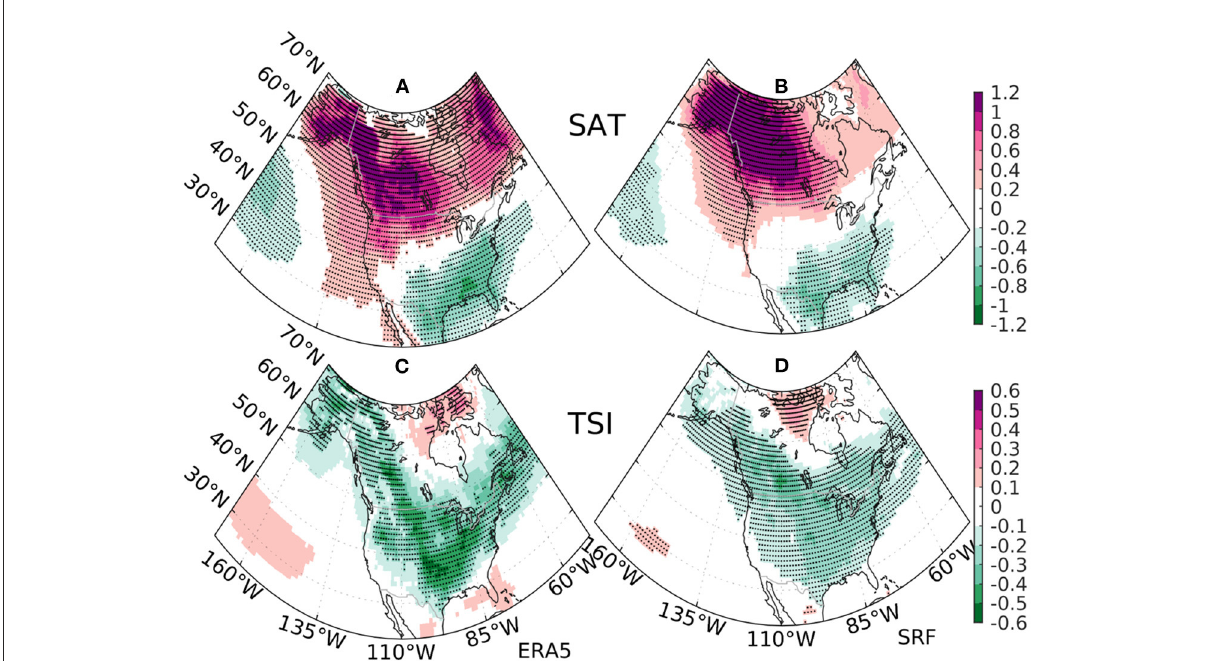
FIGURE9 The regression pattern onto the observed normalized PNA index for the DJF surface air temperature (SAT) (units in K) during 1992–2022 from (A) ERA5 reanalysis and (B) the ensemble mean estimates of SPEAR’s SRF. The same regression pattern for the DJF Temperature Swing Index (TSI) (units in K) from (C) ERA5 reanalysis and (D) the ensemble estimates of SPEAR’s SRF. The stippling indicates regression coefficients significant at 5%